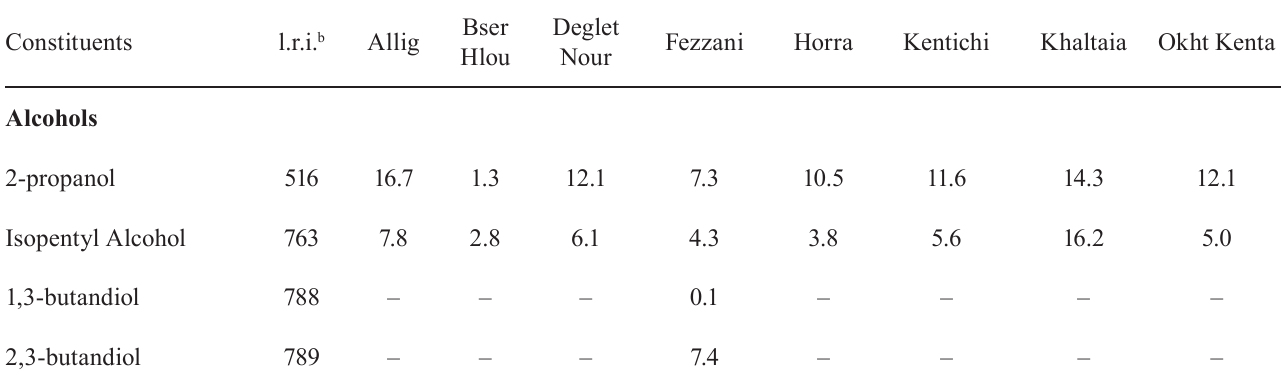
TABLE IV - Volatiles compositiona of date palm fruits obtained from eight varieties at Tamr stage (Cont.)